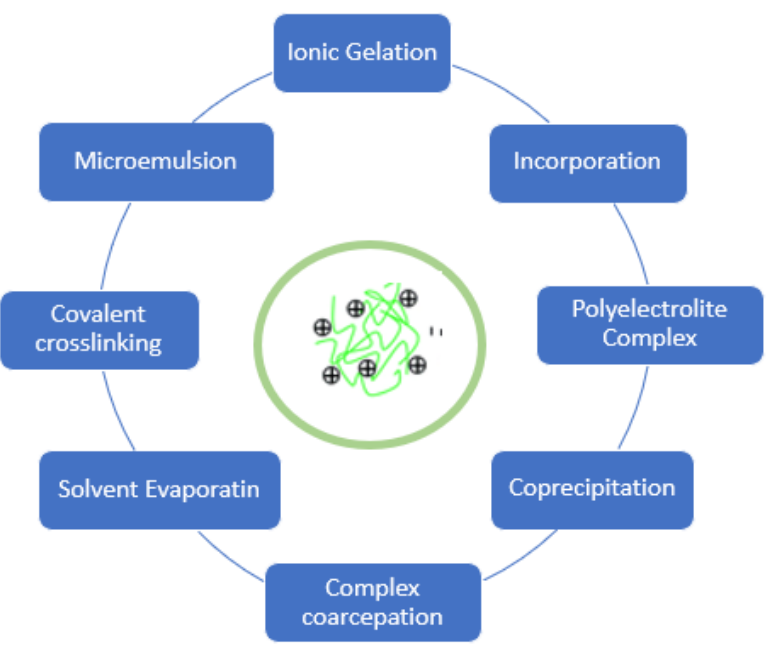
Figure 4. Preparing method of chitosan nanoparticles.